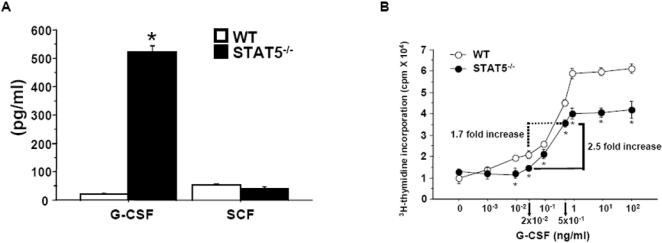
Association between increased granulopoiesis and elevated G-CSF production in STAT5−/− mice.(A) Elevated G-CSF serum levels in STAT5−/− mice. G-CSF and SCF concentrations in the serum of wild-type (WT) and STAT5−/− mice were determined by ELISA. *, significantly different from WT values with P<0.05. (B) Proliferation of bone marrow cells from wild-type and mutant mice in response to G-CSF. 2×105 STAT5−/− or control bone marrow cells were cultured with G-CSF in various concentrations for 48 hr before cells were pulsed with 3[H]thymidine for 16 hr. Note that mutant cells stimulated with 5×10−1 ng/ml G-CSF displayed a 1.7-fold and a 2.5-fold increase in proliferation, respectively, compared with control cells and mutant cells stimulated with 2×10−2 ng/ml G-CSF. (A, B) *, significantly different from WT values with P<0.05.